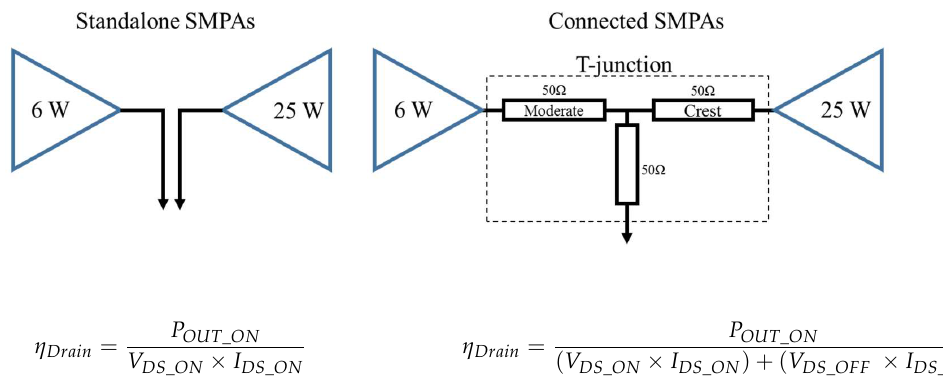
Figure 5. Standalone SMPAs and connected SMPAs and their drain efficiency equations.